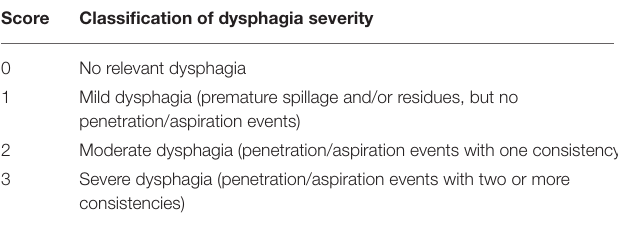
TABLE 4 | Endoscopic severity of dysphagia scale